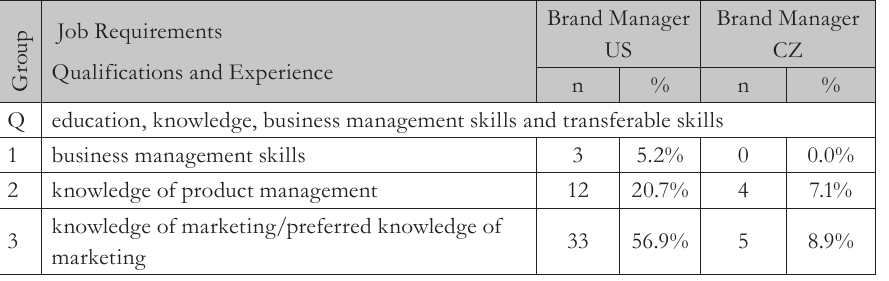
Tab. 1 – Requirements for a brand manager by advertisers in the US and the Czech Republic. Source: Author´s independent